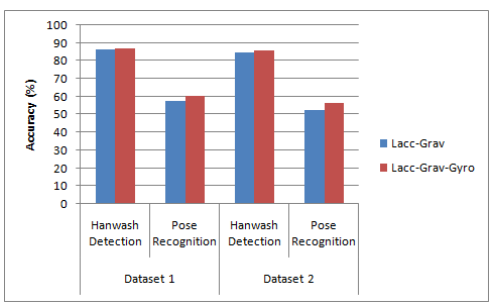
Figure 10: Accuracies for person-dependent pose recognition